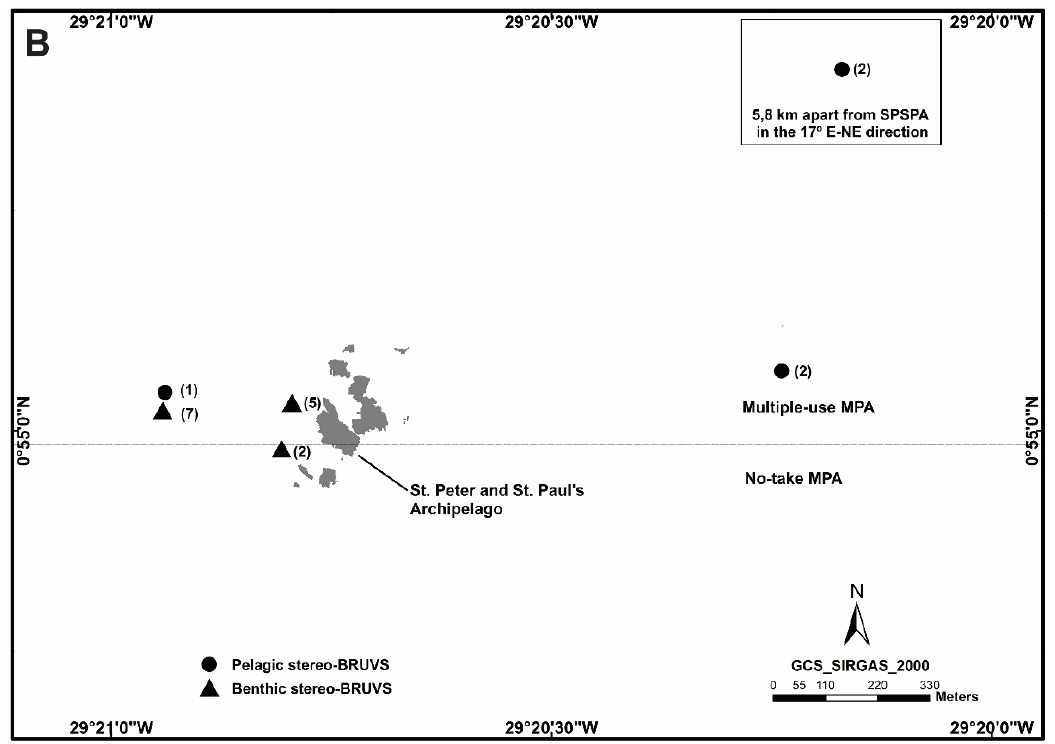
Figure 1. Study area showing the location of Saint Peter and Saint Paul’s Archipelago in the Atlantic Ocean, the multiple-use (dark gray circle) and no-take (white polygon) marine protected areas, and the other Brazilian oceanic islands ( A ), and the pelagic (dark dots) and benthic (dark triangles) stereo-BRUVS deployment sites ( B ). The number of deployments on each site is in parentheses and the dashed gray line indicates the border between multiple-use (above) and no-take (below) marine protected areas.